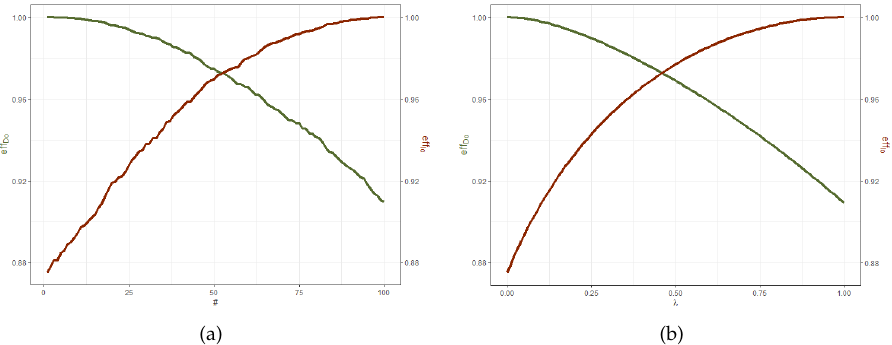
Figure 1. Efficiencies for D -optimality (in green) and I -optimality (in red) in the homoscedastic model. ( a ) Multi-objective algorithm. ( b ) Compound